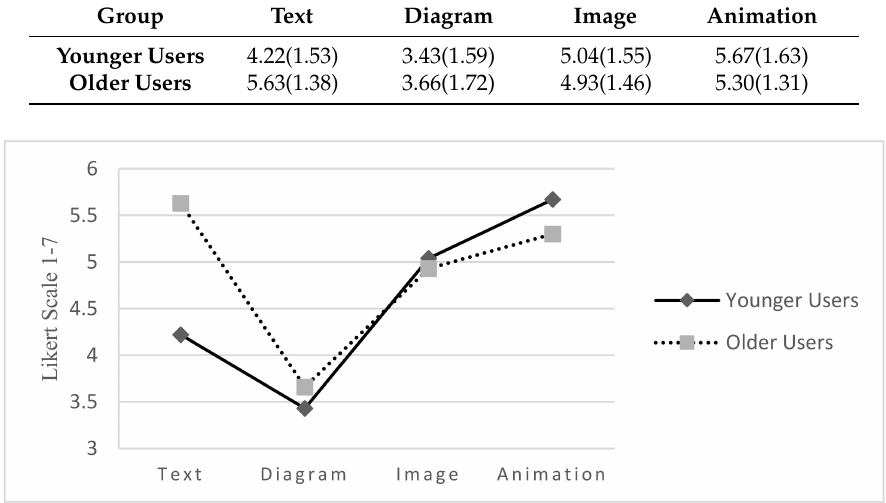
Table 19. Means and standard deviations for overall reactions (standard deviation in parentheses, unit: points; seven-point Likert scale).